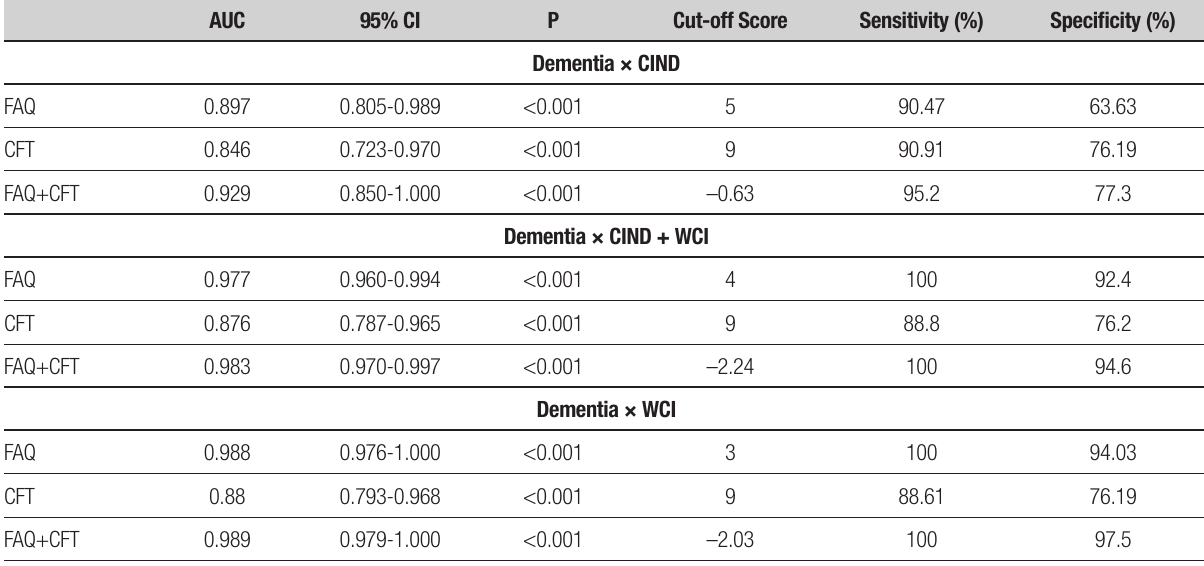
Table 3. Sensitivities and specificities of FAQ, CFT, and FAQ combined with CFT.